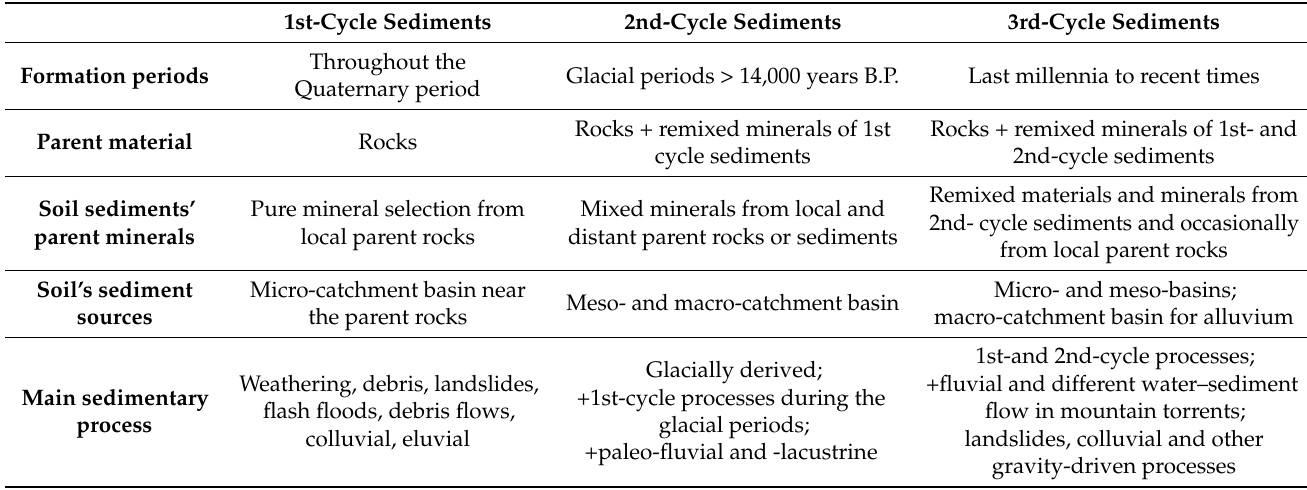
Table 2. The chemical–physical complexity of the sediments that shape vineyard soils in South Tyrol depends on their geological history and the sedimentary cycles they have undergone during the Quaternary period. High-resolution event stratigraphy can be helpful in a local terroir